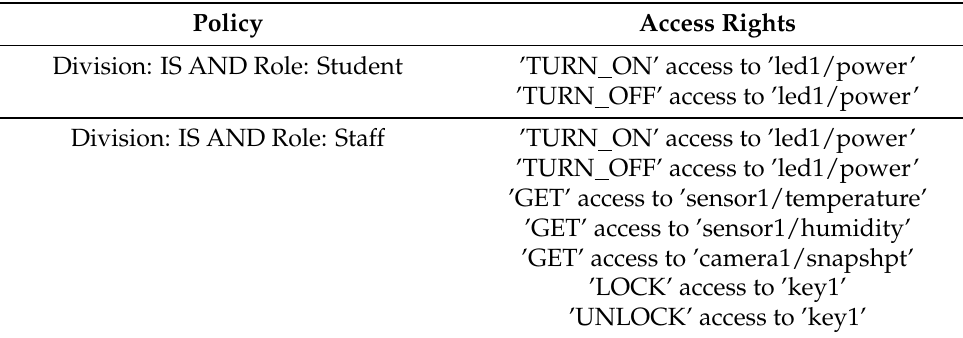
Figure 7. Proposed scheme: access right authorization. Table 1. Examples of policies and access